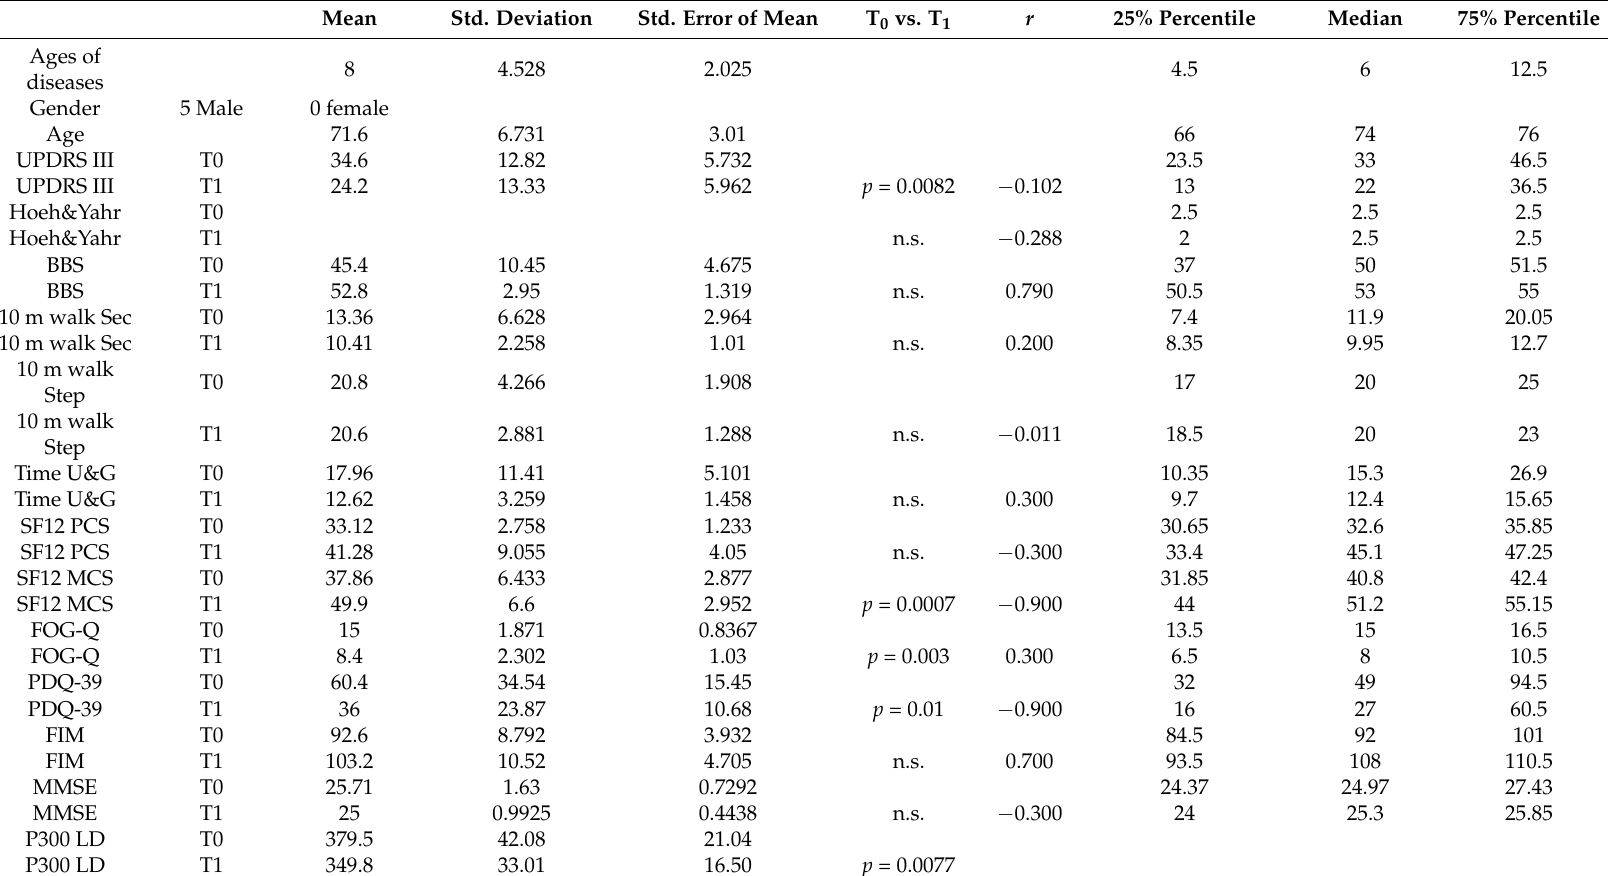
Table 1. List of outcomes measures and clinical scales administered pre and post treatment. H&Y: Hoehn & Yahr Scale; UPDRS III: Unified Parkinson’s Disease Rating Scale motor section III; MMSE: Mini Mental State Examination; FOG-Q: Freezing of gait Questionnaire; Time U&G: Timed Up & Go Test; 10 m Walk Test: Ten meters walking test (steps and seconds); BBS: Berg Balance Scale; PDQ-39: The 39-items Parkinson’s Disease Questionnaire; SF-12: Short form 12-items Healthy Survey Physical and Mental Composite Score (PCS, MCS); FIM: Functional Independence Measure; P300 Latency Duration (LD); T 0 vs. T 1 ( p ): Shapiro-Wilk test; r : Spearman’s r correlation test between ∆ T1-T0 changes of each clinical measure with P300 latency duration